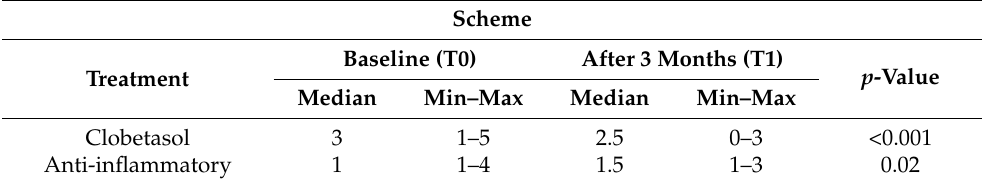
Table 2. Variation of the OLP sign score after the administration of the two protocols